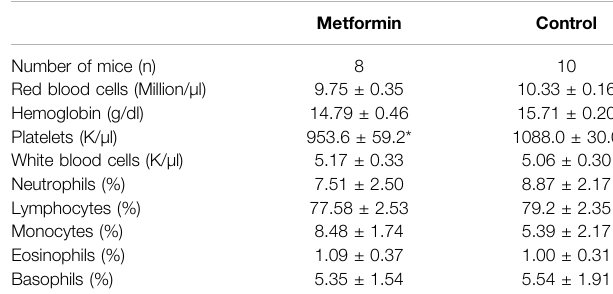
TABLE 2 | Complete blood count (CBC) data in metformin and control groups.